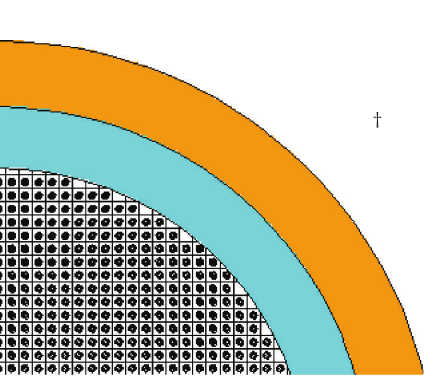
Figure 8: MCNP model without cut CPs